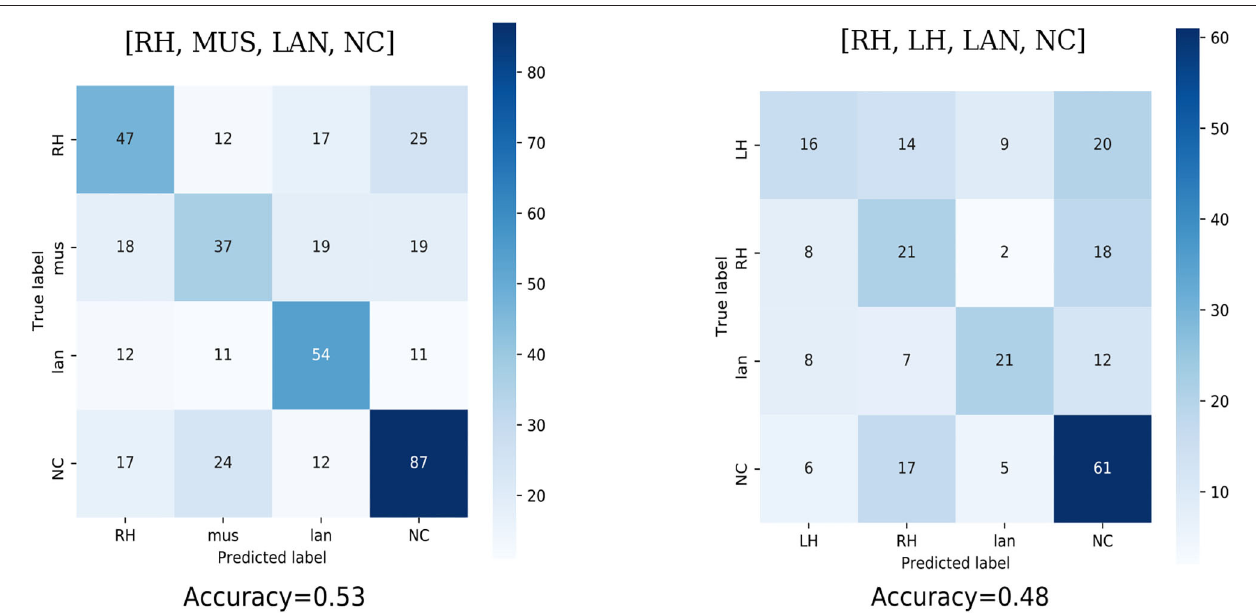
FIGURE 6 | Confusion matrix of the two 4-class paradigms tested during the training phase, from sessions S08 to S13. Each confusion matrix reports the absolute values (numbers in black) and relative percentages (color scale) to evaluate the performance of the LDA classifier. All values on the diagonal represent the correctly classified trials. At the bottom the overall classification accuracy is